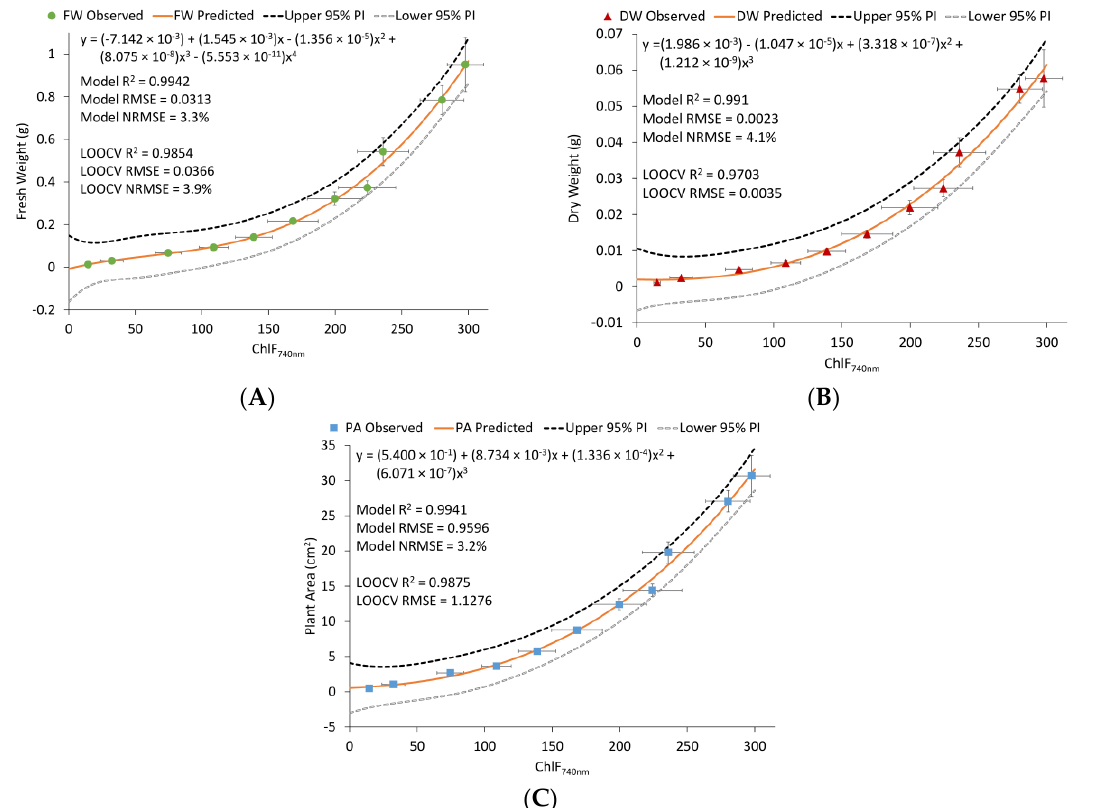
Figure 4. Final polynomial regression results for fresh weight ( A ), dry weight ( B ), and plant area ( C ), plotted as a function of chlorophyll fluorescence (ChlF 740nm ). Values represent means across four experimental replicates ( n = 12). Dashed lines indicate 95% prediction intervals (PI). Error bars show standard errors of the mean (SEM).